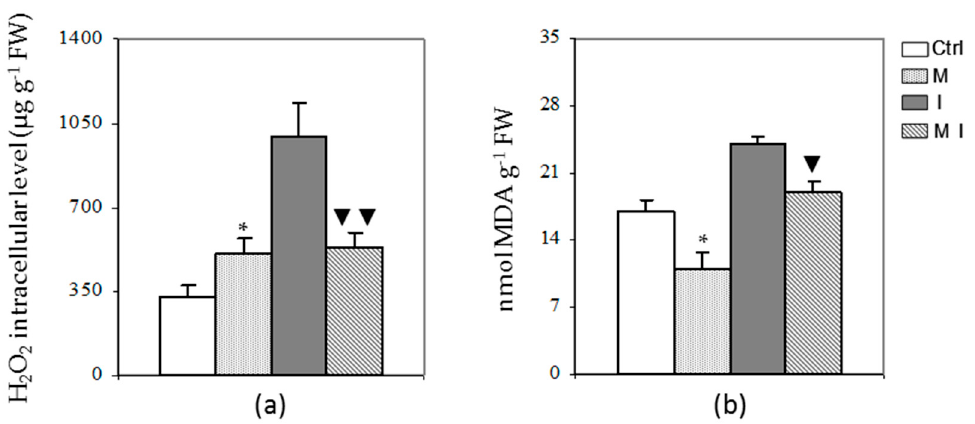
Figure 7. ( a ) Intracellular H 2 O 2 content in artichoke control plants (Ctrl), in mycorrhizal plants (M), in plants inoculated with Verticillium dahliae (I), and in mycorrhizal plants inoculated with V. dahliae (MI). The results are given as the mean values of at least five experiments ± SD; * indicates values significantly different from the control (Ctrl) by the Student’s t test with p < 0.05; ▼▼ indicates values significantly different from the artichoke inoculated with V. dahliae (I) by the Stu- dent’s t test with p < 0.01; ( b ) Lipid peroxidation level in artichoke control plants (Ctrl), in mycorrhizal plants (M), in plants inoculated with V. dahliae (I), and in mycorrhizal plants inoculated with V. dahliae (MI). The results are given as the mean values of at least five experiments ± SD; * and ▼ indicate values significantly different from the control (Ctrl) and from the artichoke inoculated with V. dahliae (I), respectively, by the Student’s t test with p < 0.05.